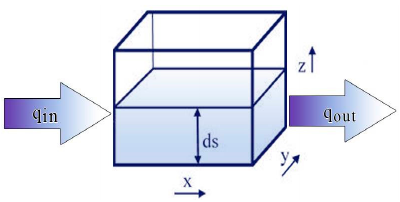
Figure 1. Microcosmic view of three-dimensional porosity medium flow condition. Water 2017 , 9 , 885